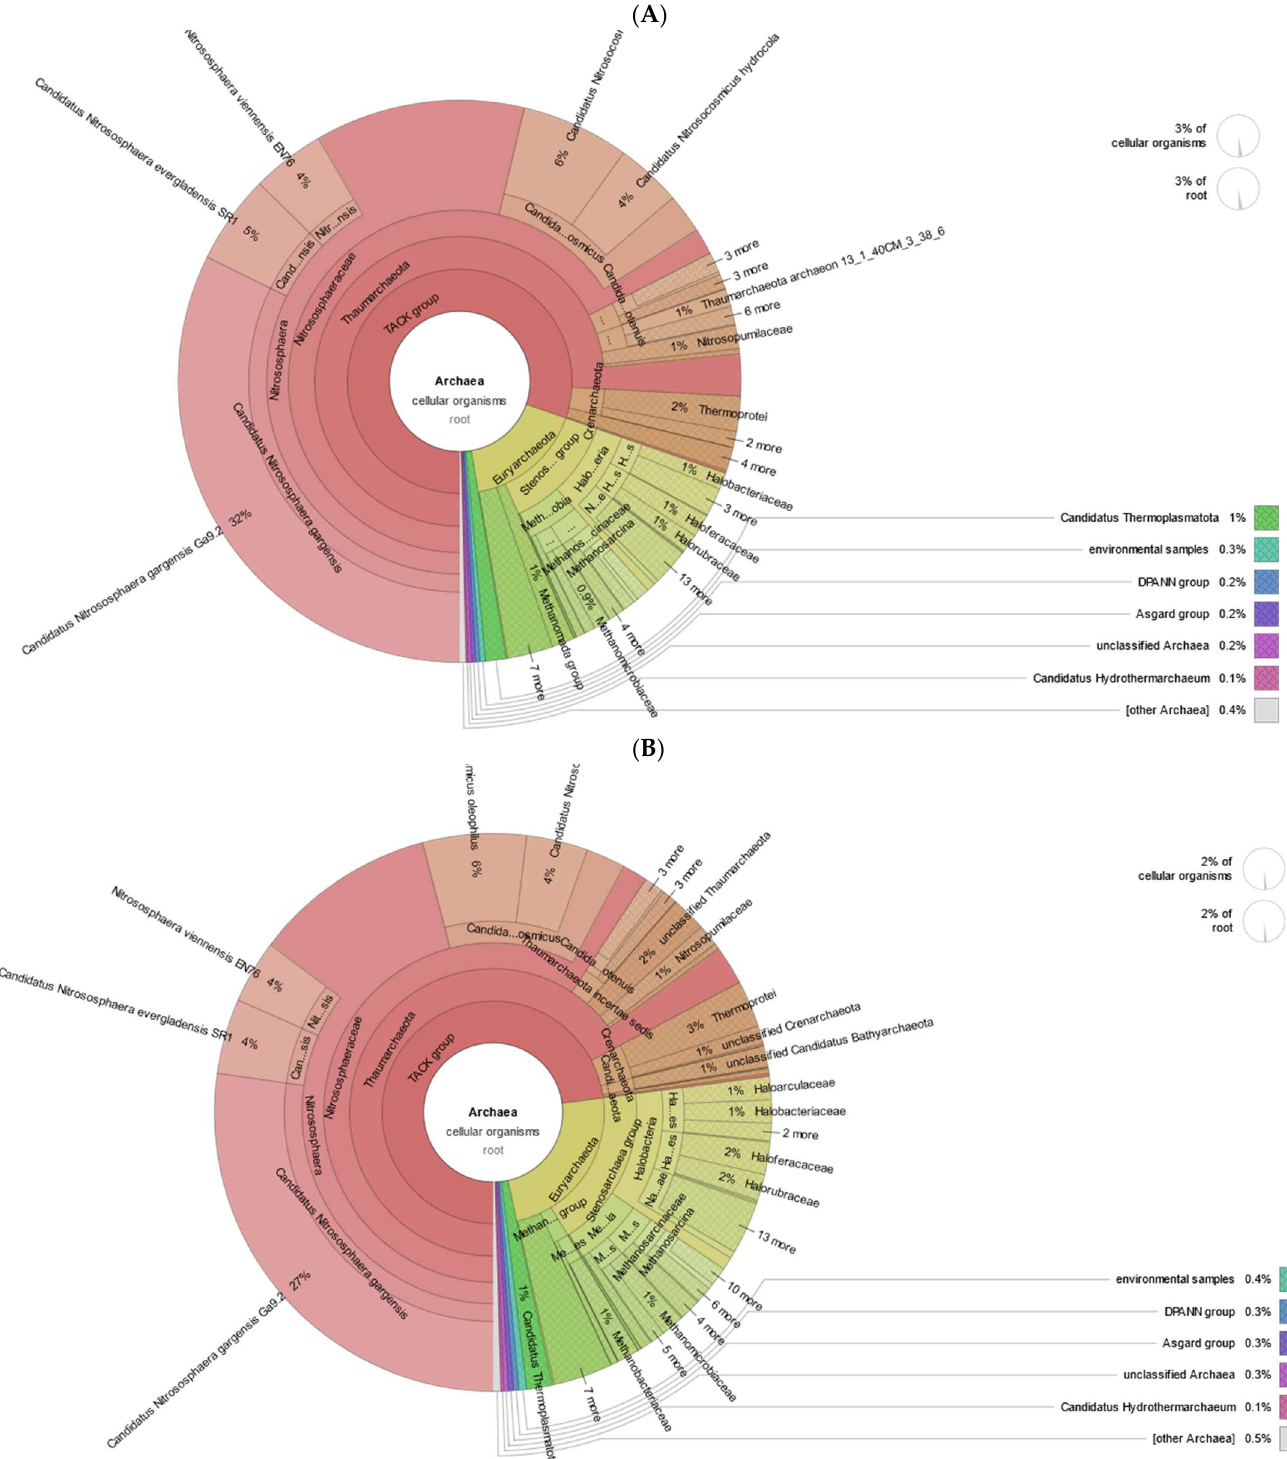
Figure 8. Krona plots of Archaea detected in metagenomic datasets. ( A ) non-polluted, ( B ) polluted soil.